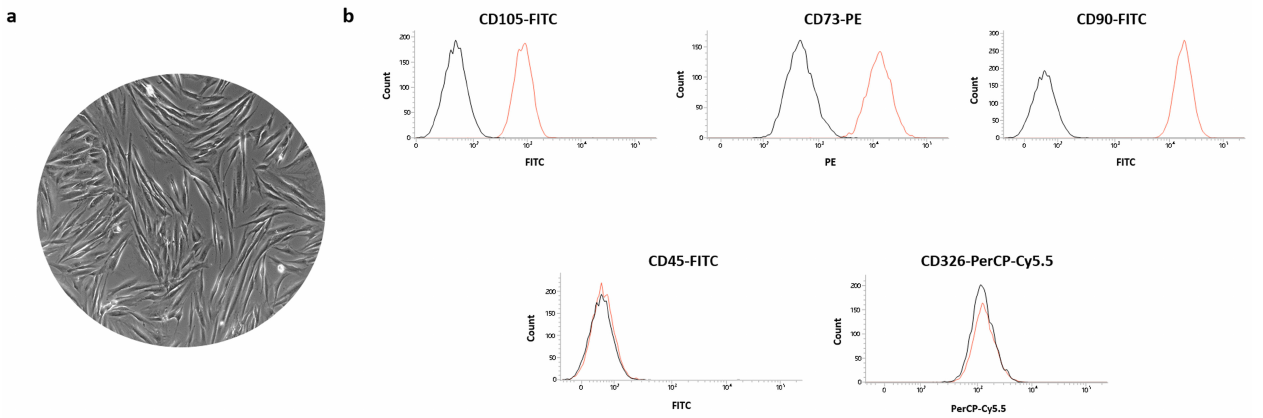
Figure 3. Characterization of hGDFs. ( a ) Representative phase contrast image of isolated hOBs. ( b ) Representative histograms of the CD105, CD73, CD90, CD45, and CD326 expressions evaluated through cytometric